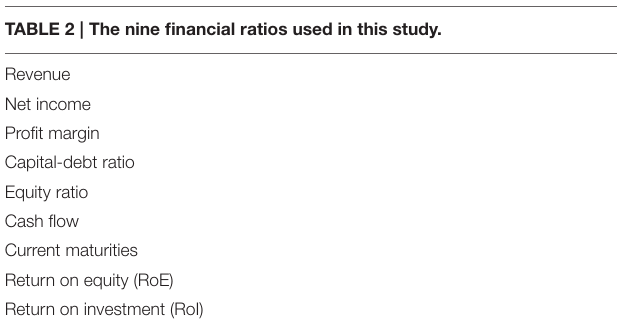
TABLE 2 | The nine financial ratios used in this